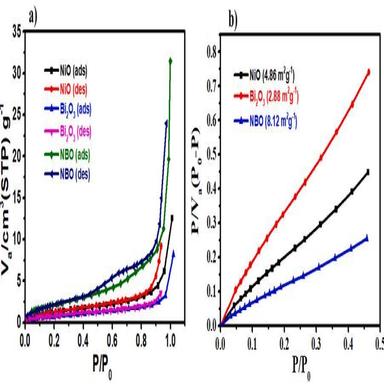
a) N2-adsorption/desorption isotherms and b) BET surface of pure NiO, Bi2O3 and NBO materials.